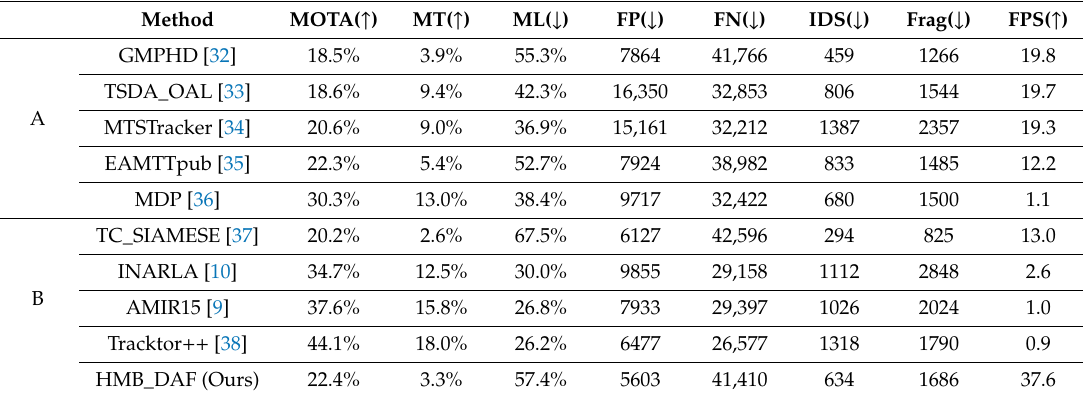
Table 4. Tracking performance on the MOT15 dataset. Best results in each category appear in bold. (A) Traditional method, (B) deep learning method. Our method is denoted by